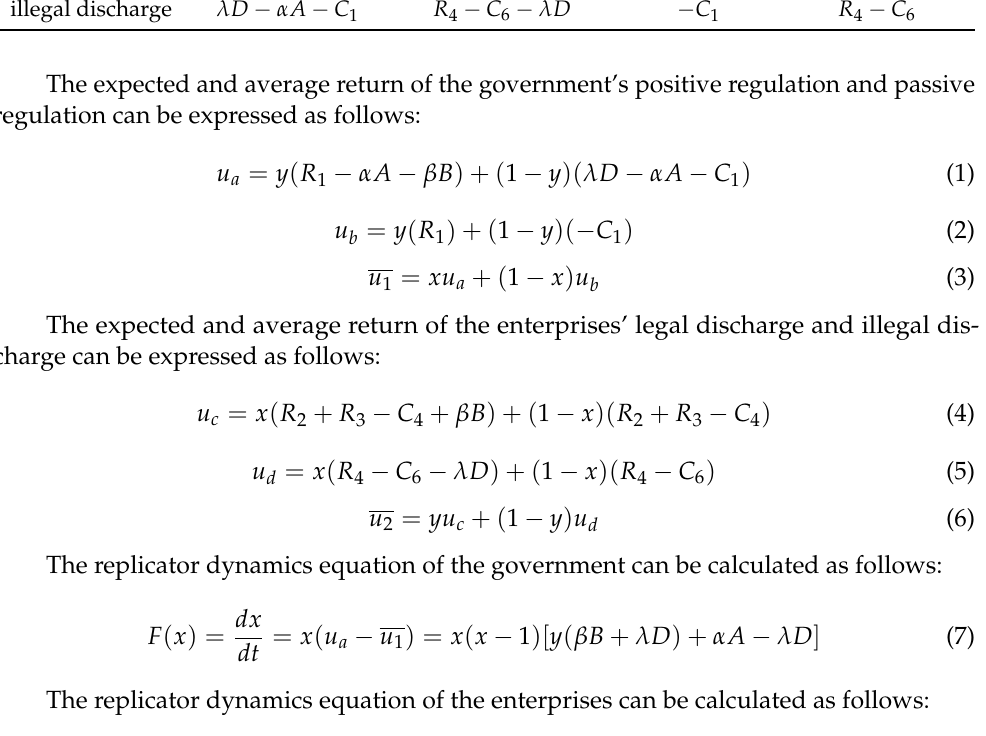
Table 2. The payoff matrix of government and enterprises. Positive Regulation Negative Regulation Government Enterprises Government